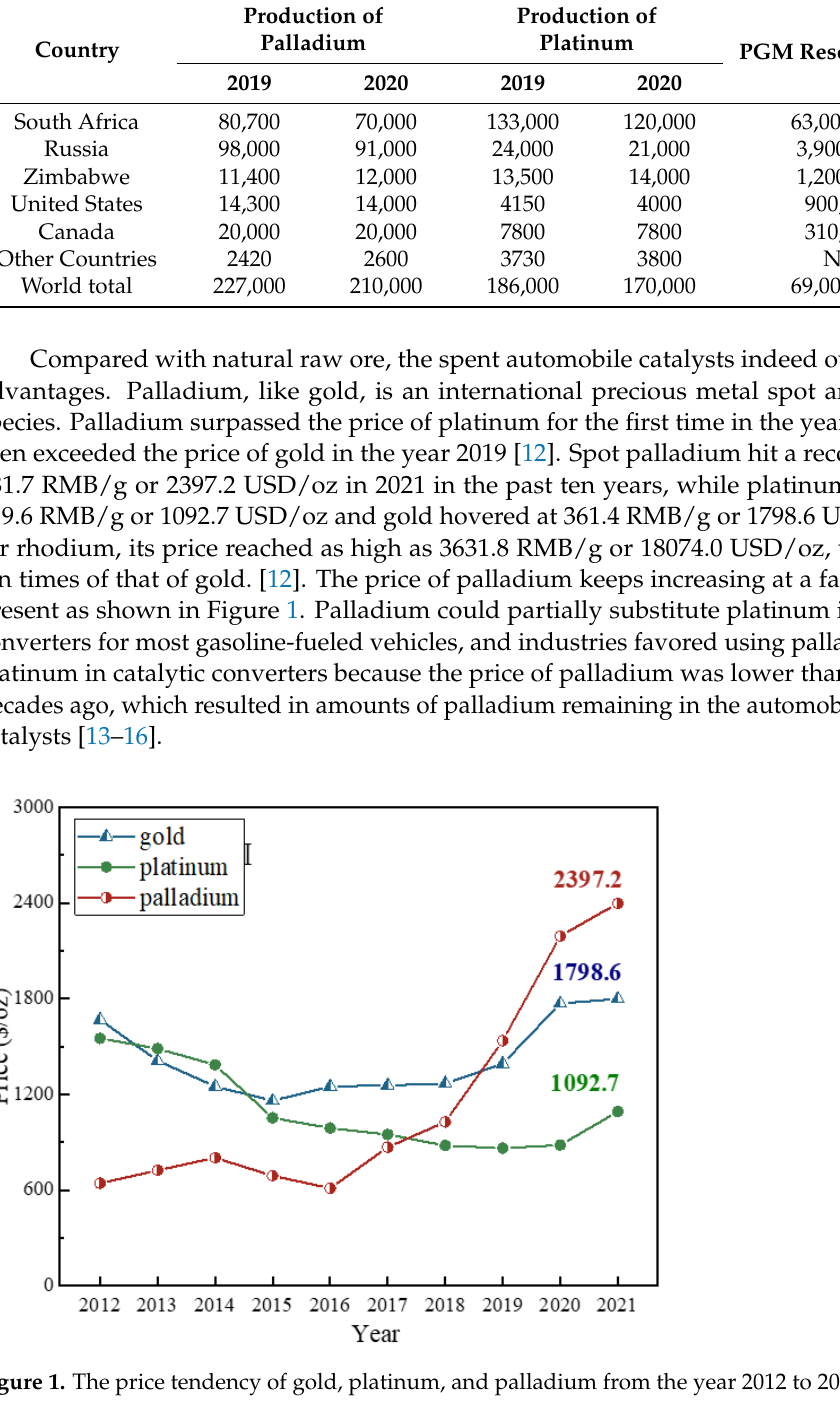
Table 1. World mine production and reserve of PGMs in the year 2019 and 2020 (Kgs). Country